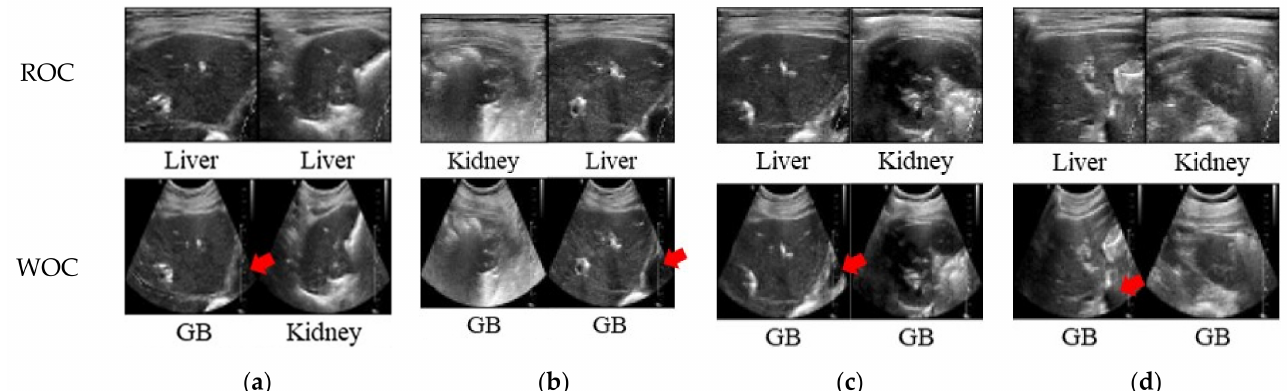
Figure 8. Image pairs correctly classified in the network trained by the RSC method, and misclassified in the network trained by the without cropping (WOC) method. Red arrows indicate anechoic region at deep depth, which causes misclassification. ( a ) AlexNet, ( b ) MobileNet, ( c ) ShallowNet, and ( d ) Xception.